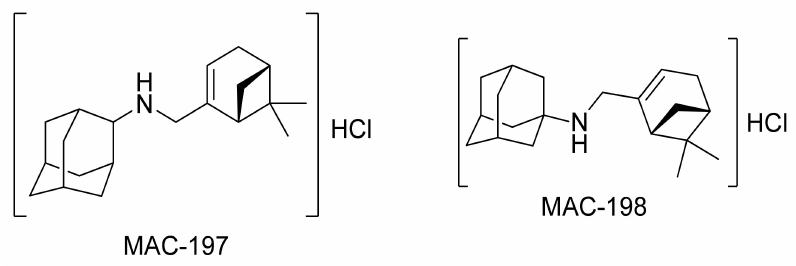
Figure 2. Chemical structure of MAC-197 and